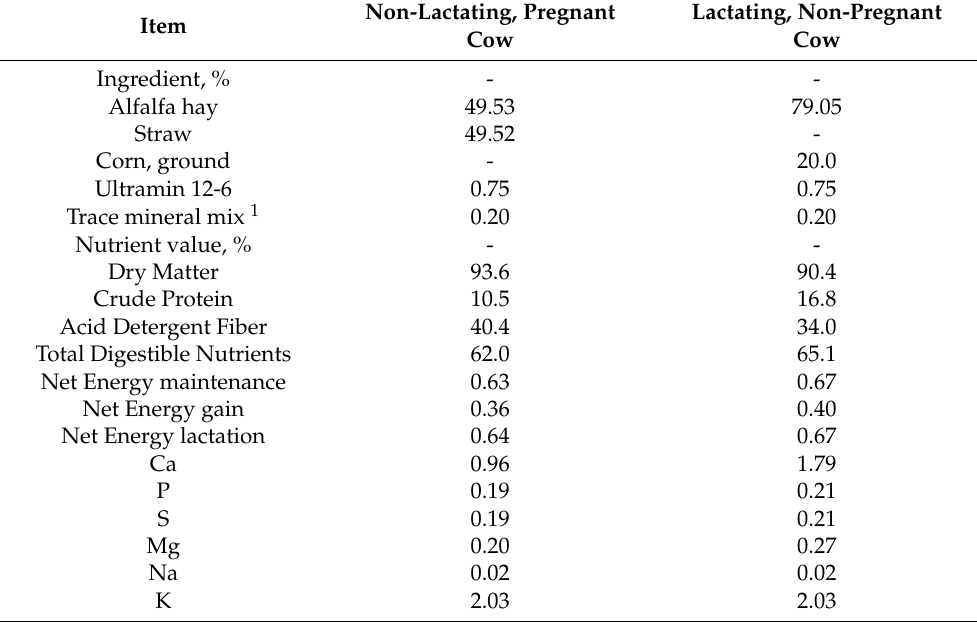
Table 1. Ingredients and nutrient composition (DM basis) of the commercially available hay pellets provided ad libitum to cows in GrowSafe pens during the 21-d DMI trials, fall 2019 and spring